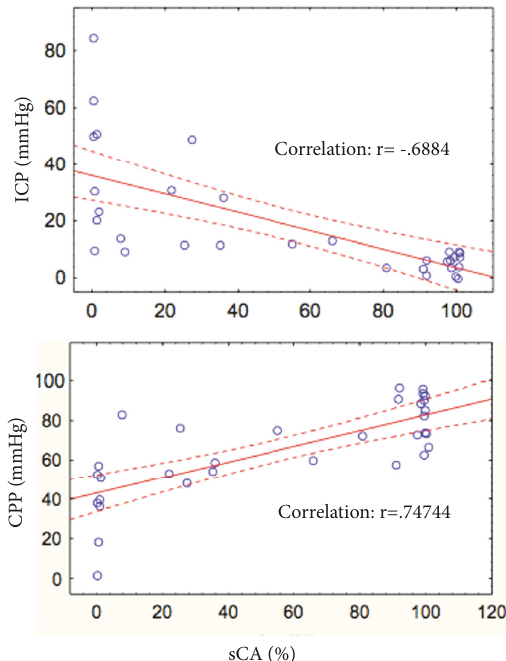
Figure 5: Pearson’s correlation analysis of ICP and sCA and of CPP and sCA; ICP (intracranial pressure), CPP (cerebral perfusion pressure), and sCA (static cerebral